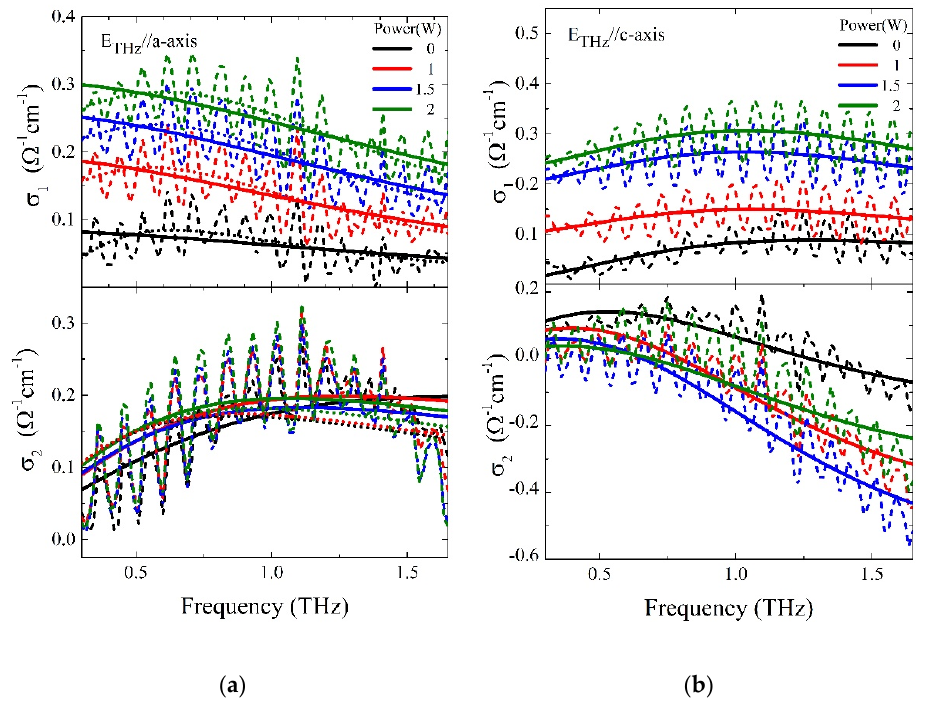
Figure 4. ( a ) Real and imaginary parts of the conductivity of the Fe-doped (010) β -Ga 2 O 3 (E THz //a-axis) at 800 nm with respect to various illumination powers; the solid lines are the fits with the Drude model, and the dashed ones are with the Drude–Smith model. ( b ) Real and imaginary parts of the conductivity of the Fe-doped (010) β -Ga 2 O 3 (E THz //c-axis) at 800 nm with respect to various illumination powers from the front surface; the solid lines are the fits with the Drude–Smith model.